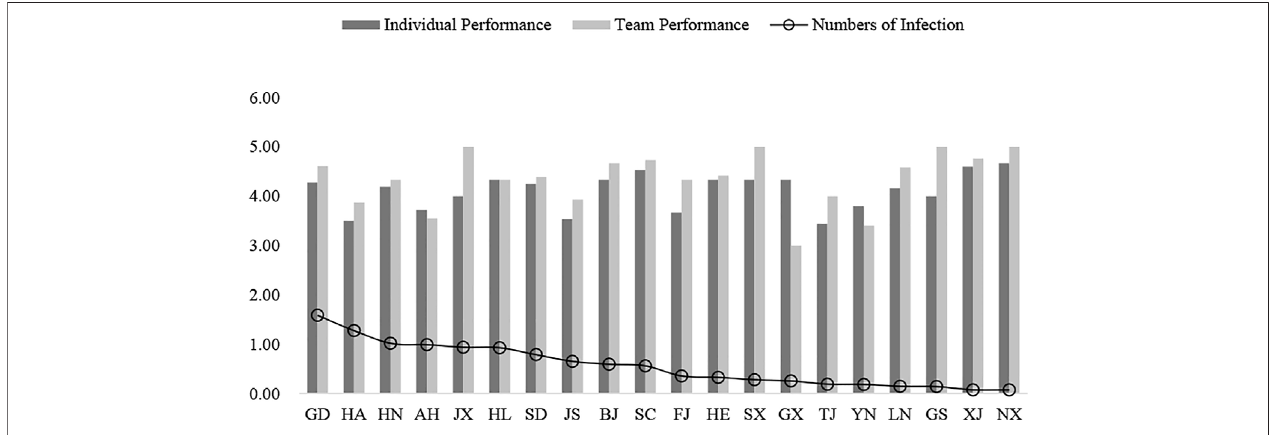
FIGURE 4 | Satisfaction and the number of con fi rmed COVID-19 infections in each province. English abbreviations of Chinese provinces: Ningxia NX, Xinjiang XJ, Gansu GS, Liaoning LN, Yunnan YN, Tianjin TJ, Guangxi GX, Shanxi SX, Hebei HE, Fujian